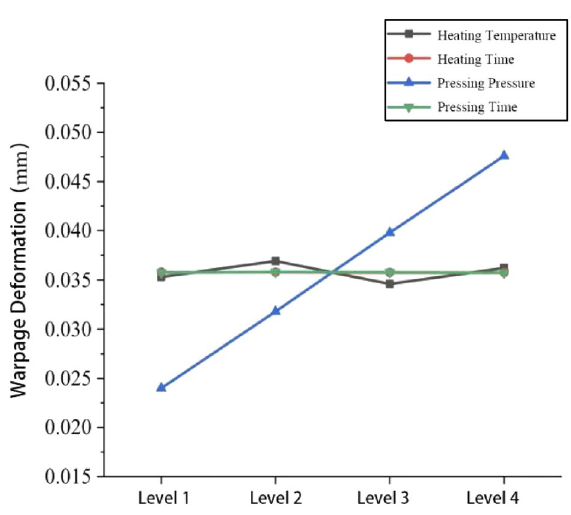
Figure 11. The degree of influence of each parameter on warpage